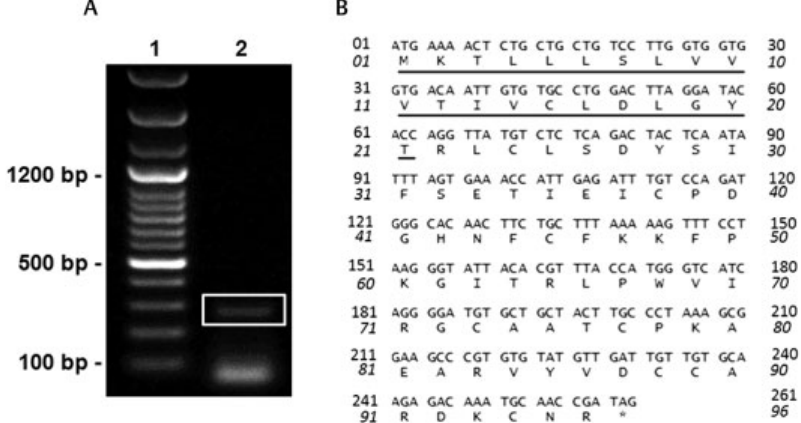
Fig. 1 NajalexincDNA transcripts ampli fi ed from Naja naja venom. ( A ) Agarose gel electrophoresis showing najalexincDNA transcripts ampli fi ed from venom-derived mRNA in Naja naja venom (Lane 1: DNA ladder, lane 2: ampli fi ed najalexin transcript [boxed]). ( B ) cDNA and deduced amino acid sequence of najalexin. The signal peptide consisting of 21 amino acid residues is underlined. The asterisk denotes the stop codon.